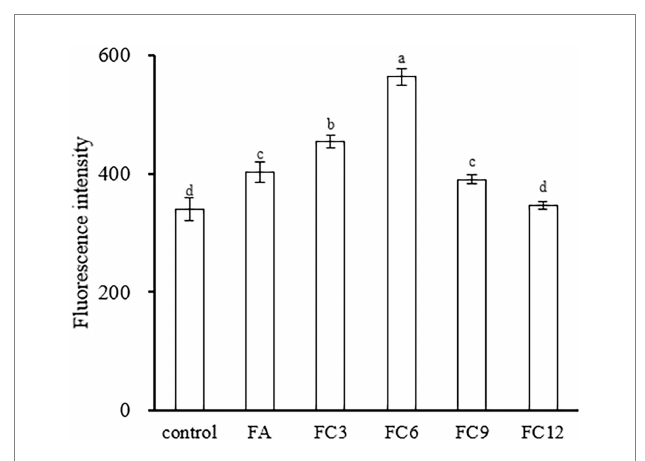
FIGURE 6 Effect on membrane potential of Pseudomonas